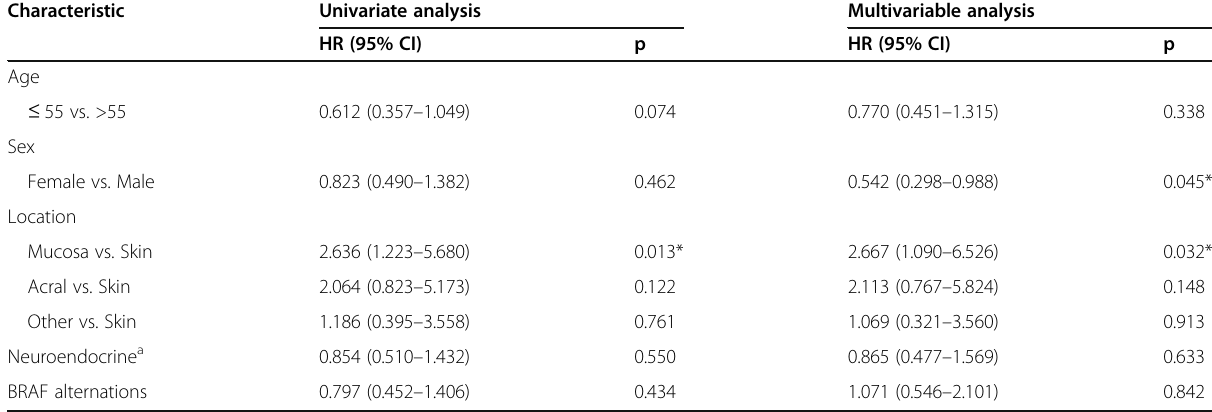
Table 7 Univariate and multivariable Cox proportional hazards model for PFS in stage I-II melanoma patients